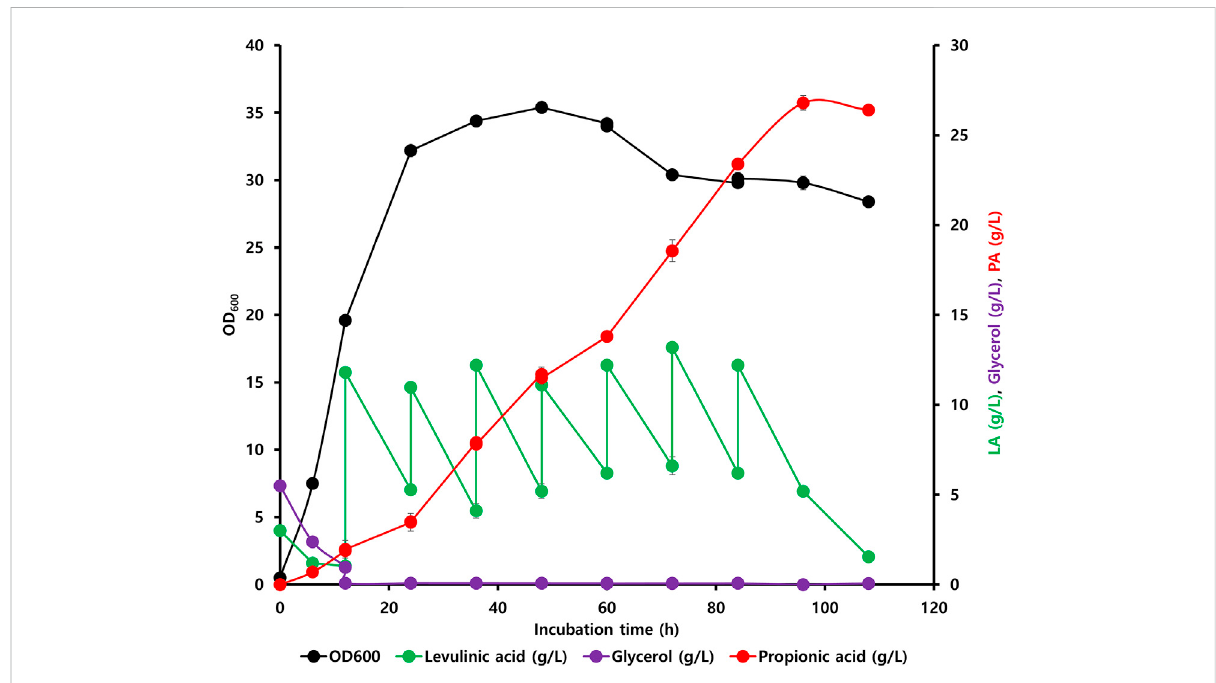
FIGURE 4 Fed-batch fermentation led by the engineered EM42: Δ CE: yciA : ygfH strain exhibiting an LA-based PA synthesis